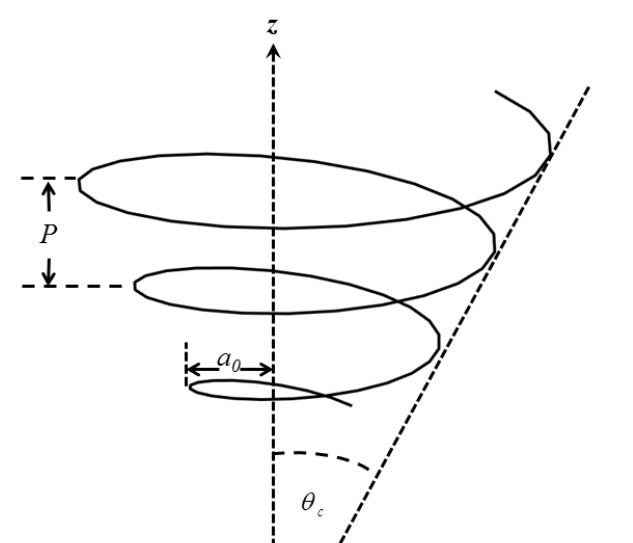
Figure 1: Dimensions of a Right-Handed 3-Turn Conical Coil